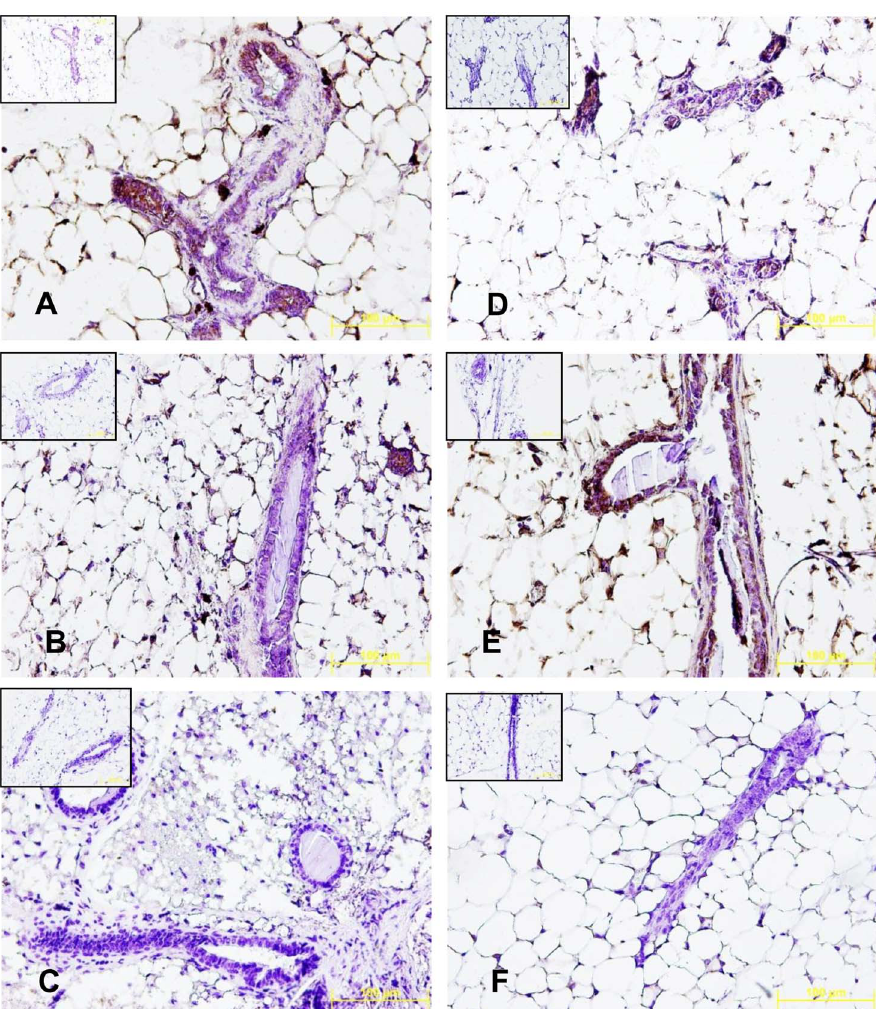
Figure 4. Effects of EGF on the induction of GPR30 by immunohistochemistry. C57 wild type, a ERKO and b ERKO mice were either injected with 25 ng EGF or vehicle subcutaneously daily for 5 days. The glands were dissected, fixed in formalin and 5 micron sections were processed for immunohistochemical staining. The sections were incubated with blocking reagent followed by GPR30 primary antibody and biotinylated secondary antibody. Antigen specific staining was visualized using DAB (brown) as a chromogen and nuclear counterstaining was done using hematoxylin (blue). Negative controls (sections not incubated with GPR30 antibodies) are shown as an inset for each condition. Results show that EGF induces GPR30 (brown) in the mammary glands of a ERKO mice. A. Vehicle, Control; B. Vehicle, a ERKO; C Vehicle, b ERKO; D. EGF, Control; E. EGF, a ERKO; F. EGF, b ERKO.